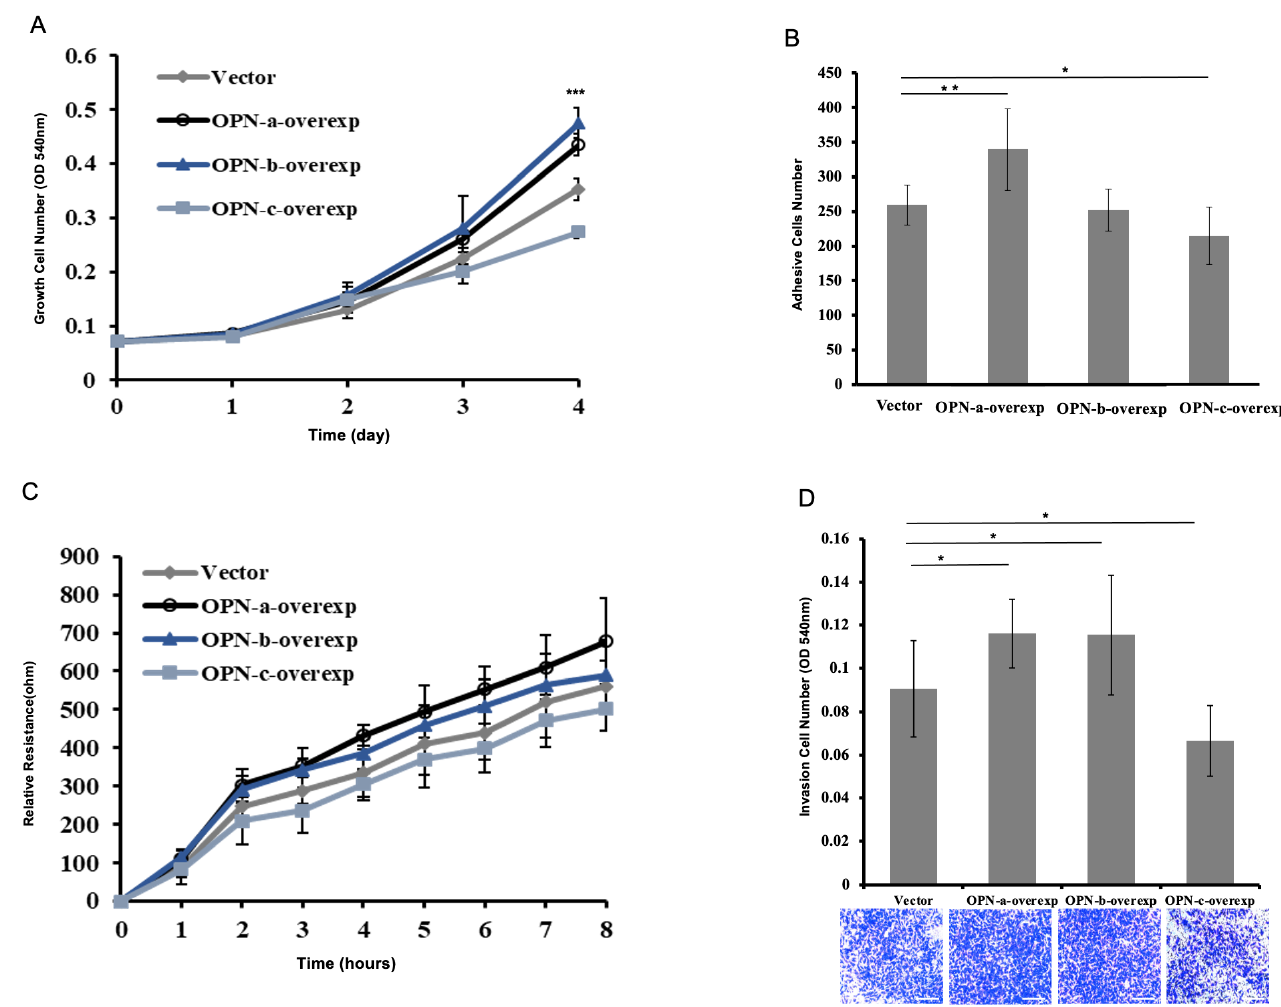
Figure 3. Effect of OPN variants on malignant properties of gastric cancer cells. ( A ) Compared with OPN-vector, OPN-a and OPN-b overexpression in HGC-27 increased in vitro growth, especially OPN-b, while OPN-c showed an inhibitory effect on tumor growth. ( B ) OPN-a overexpression in HGC-27 increased in vitro cellular adhesion, while OPN-c overexpression resulted in a remarkable reduction in the adhesion ability of HGC-27 cells. OPN-b did not show a noticeable effect on cellular adhesion. ( C ) Overexpression of OPN-a in HGC-27 cells showed an increased tendency in post-wound migration as indicated by the ECIS system. OPN-c overexpression resulted in a reduction in the migratory ability of HGC-27 cells. OPN-b did not show a noticeable effect on cellular migration. There were no statistically significant differences in both OPN-a-overexpression and OPN-c-overexpression groups at the 8th hour. ( D ) Compared with vector control cells, overexpression of OPN-a and OPN-b significantly promoted the transwell invasion. However, the high level of OPN-c remarkably decreased in vitro invasiveness (scale bars = 100 m). * p < 0.05, ** p < 0.01, *** p < 0.001.